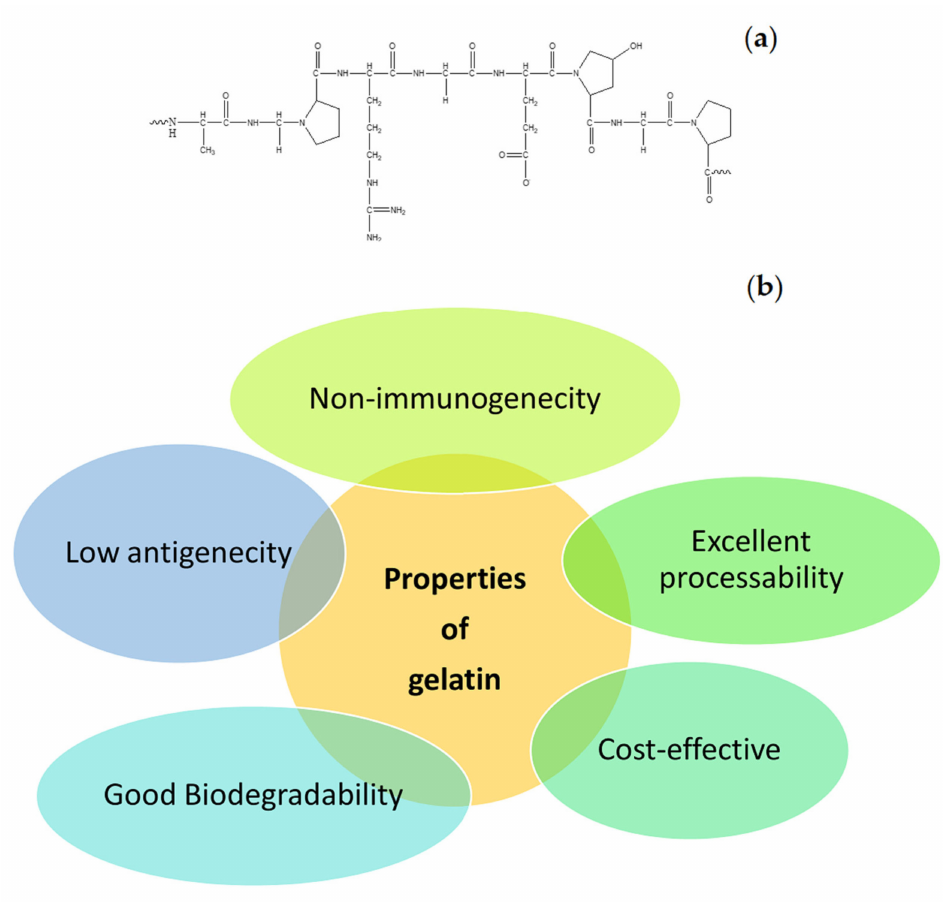
Figure 4. ( a ) Basic molecular structure of gelatin ( b ) Properties of